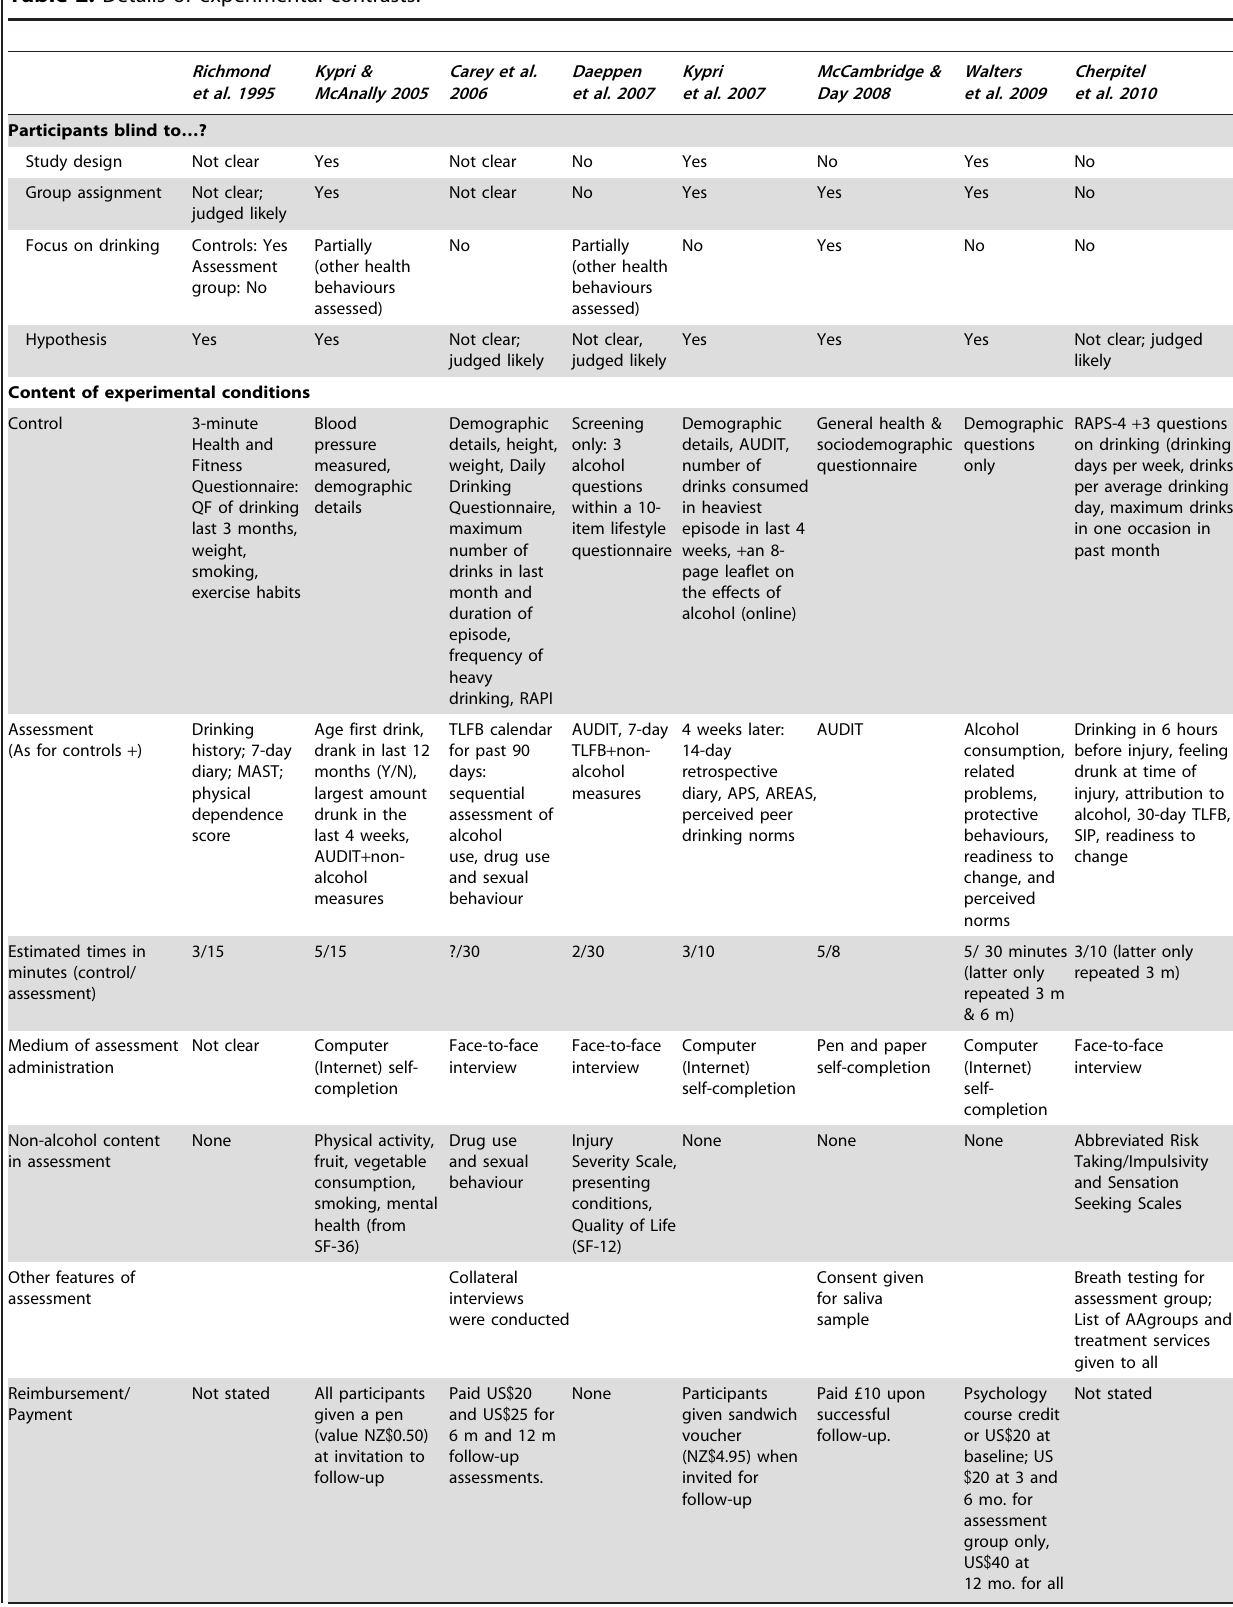
Table 2. Details of experimental